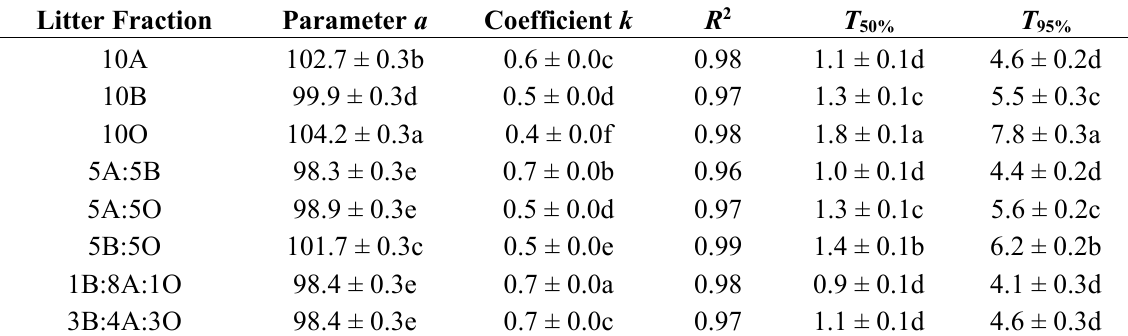
Table 3. Decomposition parameters ( a ), coefficient k and time (year) required for different levels of decomposition ( t 50% and t 95% mass loss) for the eight litter treatments (means ± SE; n = 3)